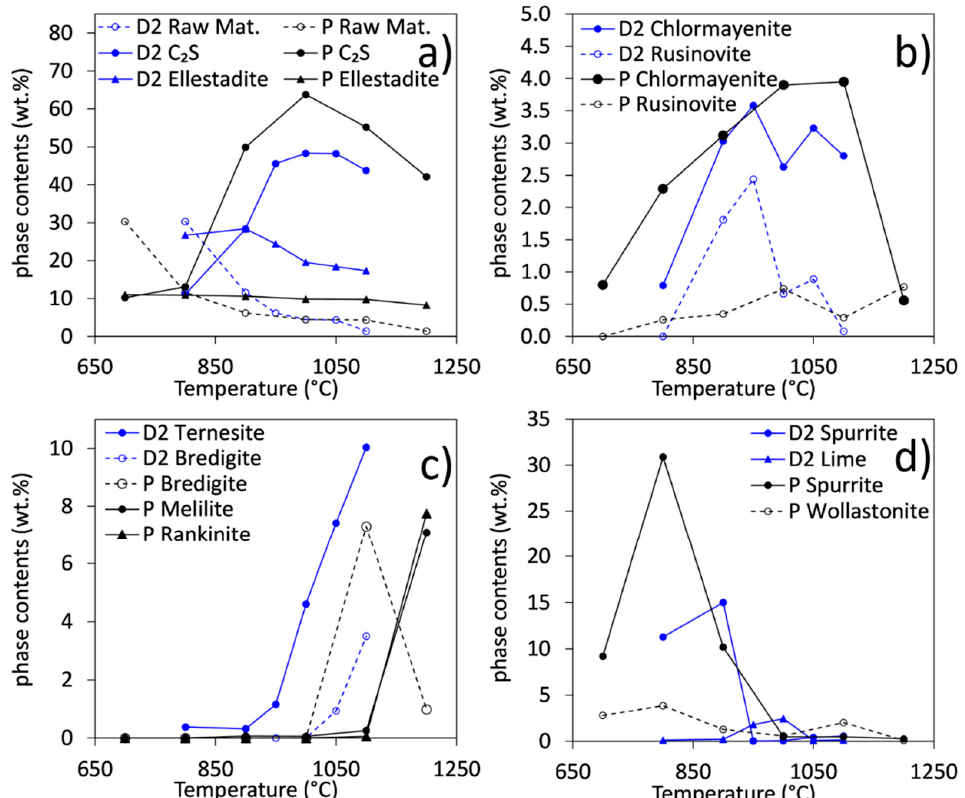
Figure 1. Synthetic crystalline phase contents in samples D2 and P after thermal treatment at 700–1200 °C. Only phase contents > 2 wt% are shown. ( a ) Consumption of raw materials (quartz + calcite + anhydrite) and formation of main products C2S ( β -C2S + α ` H-C2S) and ellestadite; ( b ) Chlorine-containing intermediate phases (chlormayenite and rusinovite);( c ) Intermediate phases (spurrite, wollastonite and lime; lime in P < 0.5 wt%, wollastonite in D2 < 1.5 wt%); ( d ) Minor phases (chlorine free) formed at high temperatures: ternesite, bredigite, melilite, and rankinite, ternesite in P < 0.5 wt%, rankinite < 1 wt.%, and melilite < 1.5 wt% in D2.